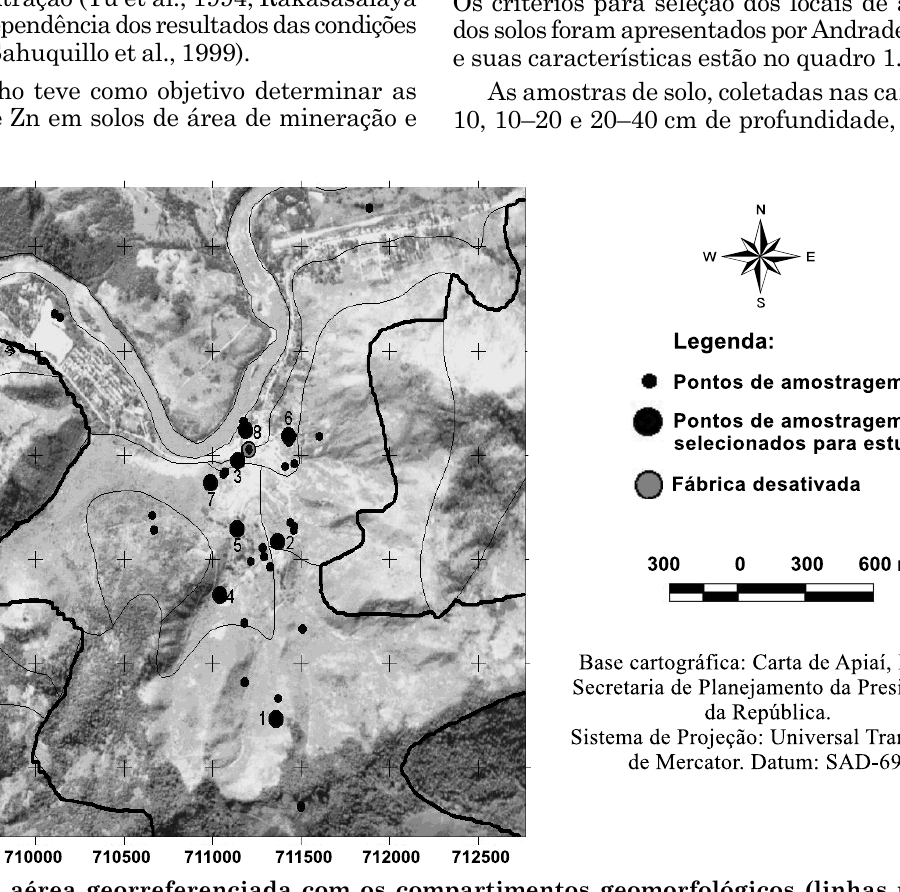
Figura 1. Foto aérea georreferenciada com os compartimentos geomorfológicos (linhas mais finas), localização da fábrica abandonada e locais de coleta (1 a 8) dentro da área selecionada para o estudo (linha mais espessa). Os pontos menores representam a coleta prévia de solos para reconhecimento da área e definição dos ambientes em função das diferentes formas de contaminação, conforme detalhes apresentados por Andrade et al.